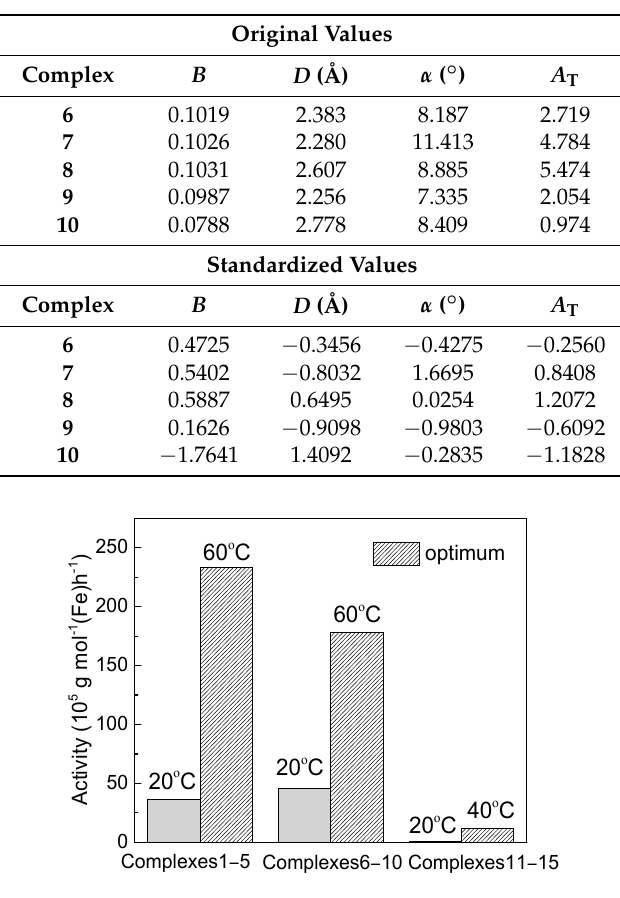
Figure 2. Comparisons of the average catalytic activities for complexes 1 – 5 , 6 – 10 and complexes 11 – 15 at room and optimum temperatures, respectively.